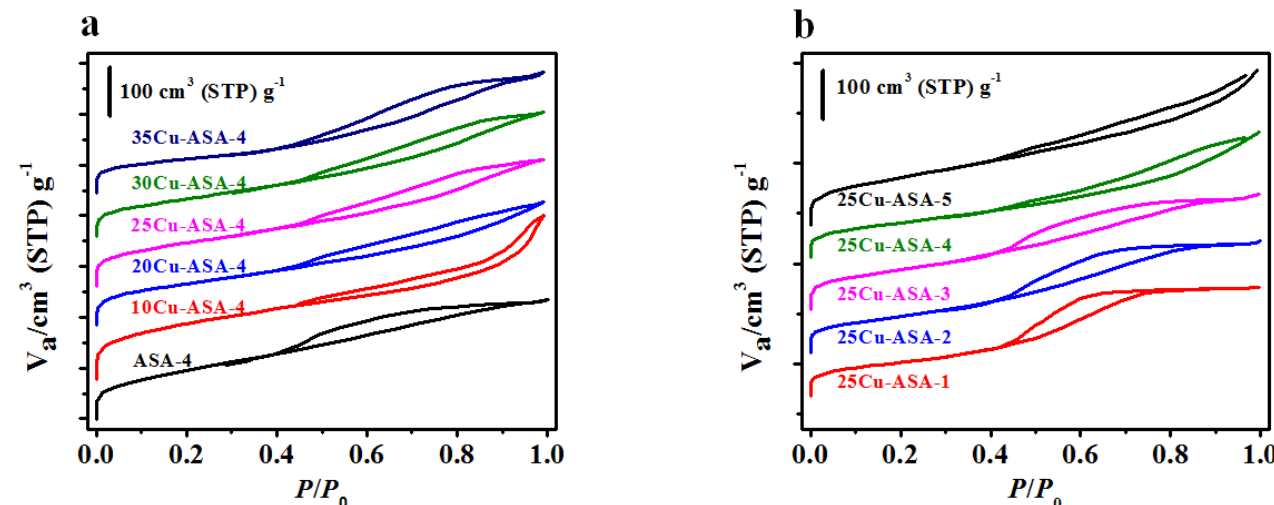
Figure 3. N 2 adsorption/desorption isotherms of x Cu–ASA-4 ( a ) and 25 Cu–ASA- y ( b ) catalysts.